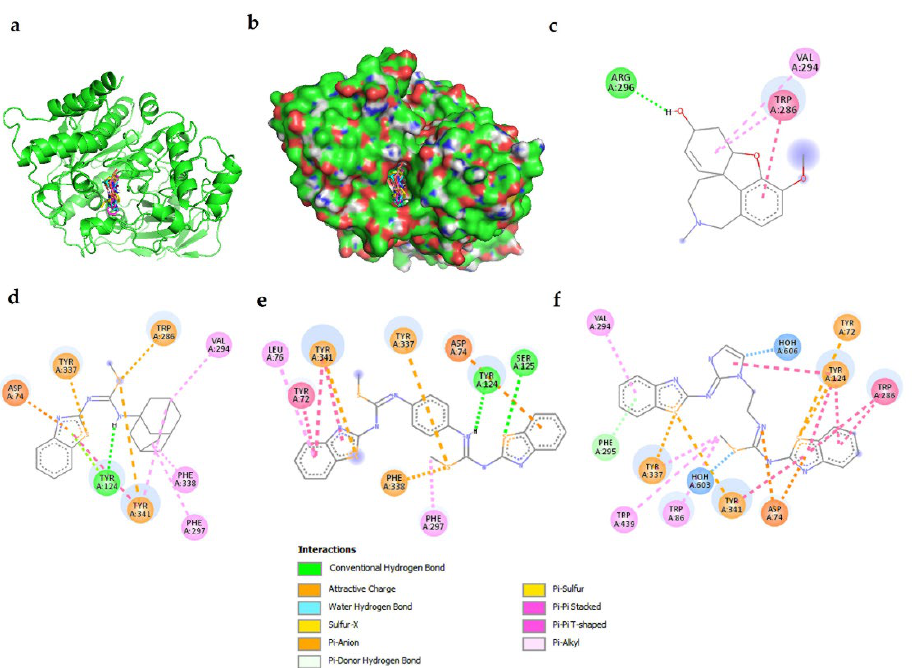
Figure 4. Non-bonded interactions obtained by docking simulations between AChE and the com- pounds. ( a ) Galantamine and 3f , 3r , 3t compounds with AChE. ( b ) All compounds were recognized at PAS site near to the entrance of the gorge to the catalytic site. ( c ) AChE and galantamine. ( d ) AChE and 3f . ( e ) AChE and 3r. ( f ) AChE and 3t .